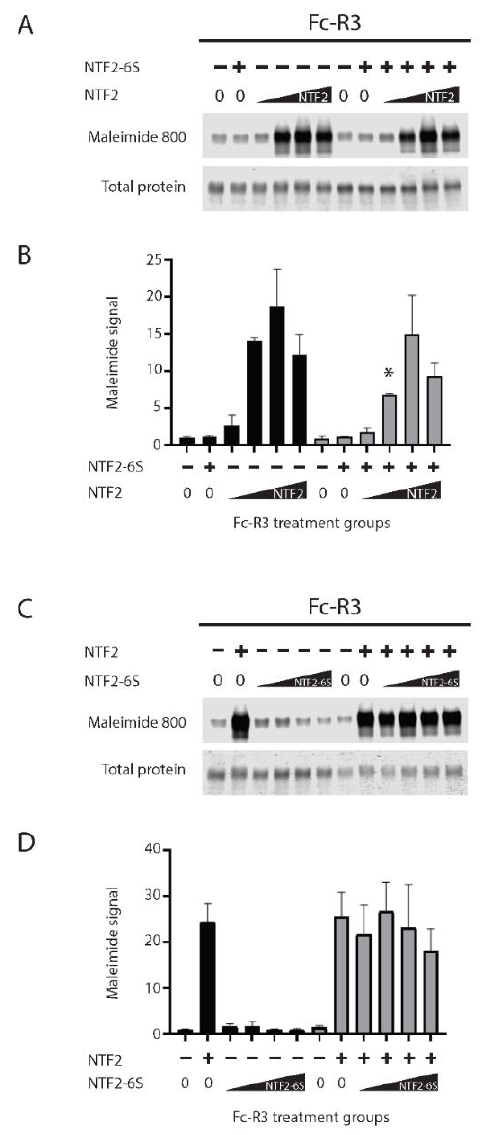
Figure 3. The role of cysteines in NTF2 on trans-reduction of target protein. ( A ) Fc-R3 (Fc-fusion to the first three EGF-like domains of NOTCH3 with the R90C mutation; 200 ng) was treated with either 0 or 2 µ g NTF2-6S (NTF2 peptide in which all cysteines were replaced by serine) and an increasing dose of NTF2 (0, 0.01, 0.1, 1.0, or 2.0 µ g) followed by maleimide dye labeling and gel scanning (upper panel). Simply Blue stain was used for detection of total protein loaded (lower panel). ( B ) Quantification of the trans-reduction of Fc-R3 by 2 µ g NTF2-6S and an increasing dose of NTF2. This showed the ability of 2 µ g NTF2-6S to partially compete for NTF2 reaction only in one comparison group (0.1 µ g NTF2 showed decreased dye reactivity with NTF2-6S compared to without NTF2-6S; * p < 0.05). ( C ) Fc-R3 was treated with either 0 or 0.5 µ g NTF2 and an increasing dose of NTF2-6S (0, 0.01, 0.1, 1, 2 µ g) followed by maleimide dye labeling and gel scanning (upper panel). Total protein loading was detected by Simply Blue stain (lower panel). There was no evidence for a consistent ability of NTF2-6S to compete against NTF2. ( D ) Quantification of trans-reduction of Fc-R3 by 0.5 µ g NTF2 with increasing doses of NTF2-6S. Reaction volumes were 5 µ L followed by addition of 10 µ L labeling mix. All experiments were performed at least three times and included in the final quantified